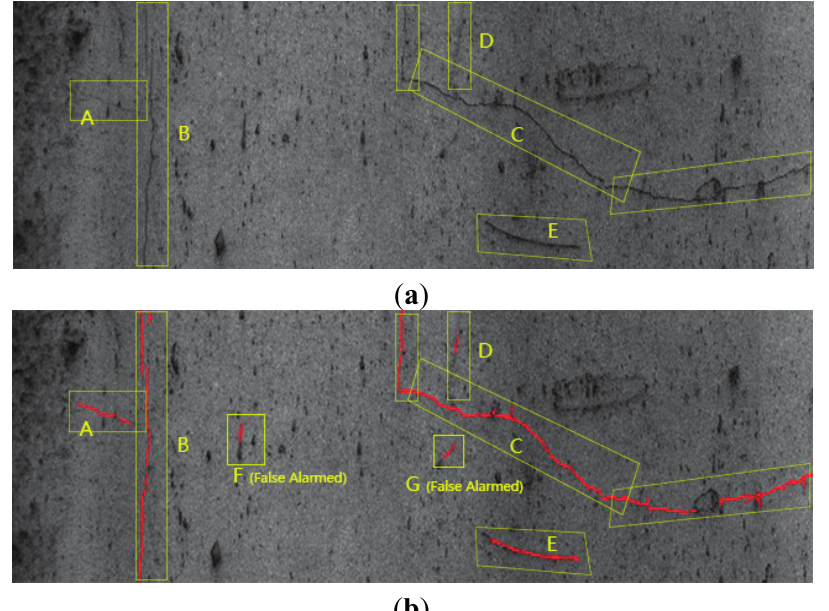
Figure 11. Examples of practical detection results: ( a ) and ( c ) original images with visual detection results; ( b ) and ( d ) automatic detected results of ( a ) and ( c ),